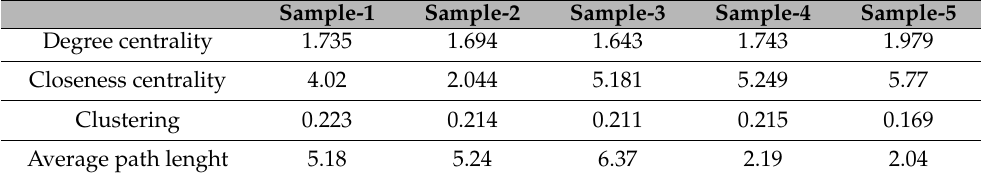
Table 3. Social network analysis.